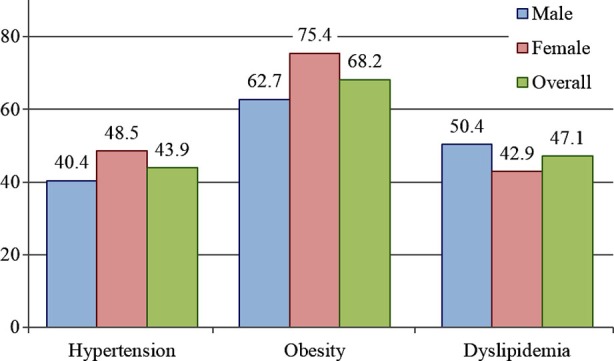
Frequency of dyslipidemia, obesity and hypertensive subjects.P-value < 0.05 was considered statistically significantP-value was found to be statistically significant in all cases.